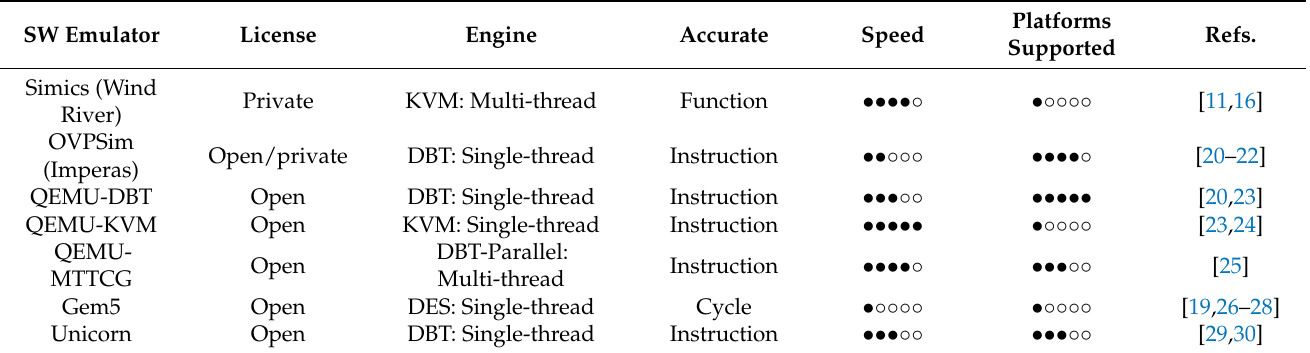
Table 1. Comparison of most used software